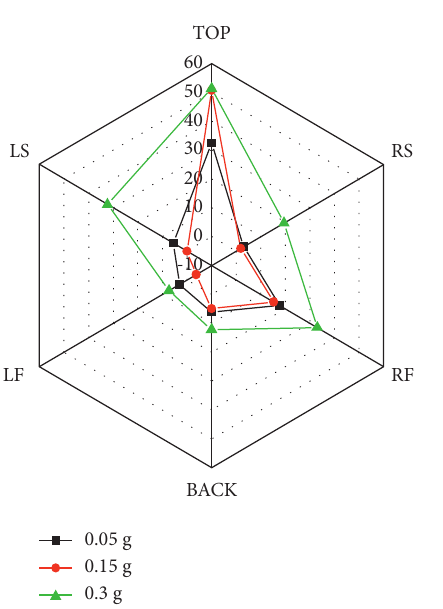
Figure 14: Circumferential strain inside the tunnel portal (4Hz).